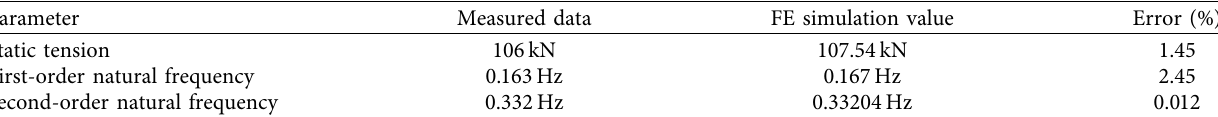
Table 4: Finite element simulation results compared with the measured values under gravity.